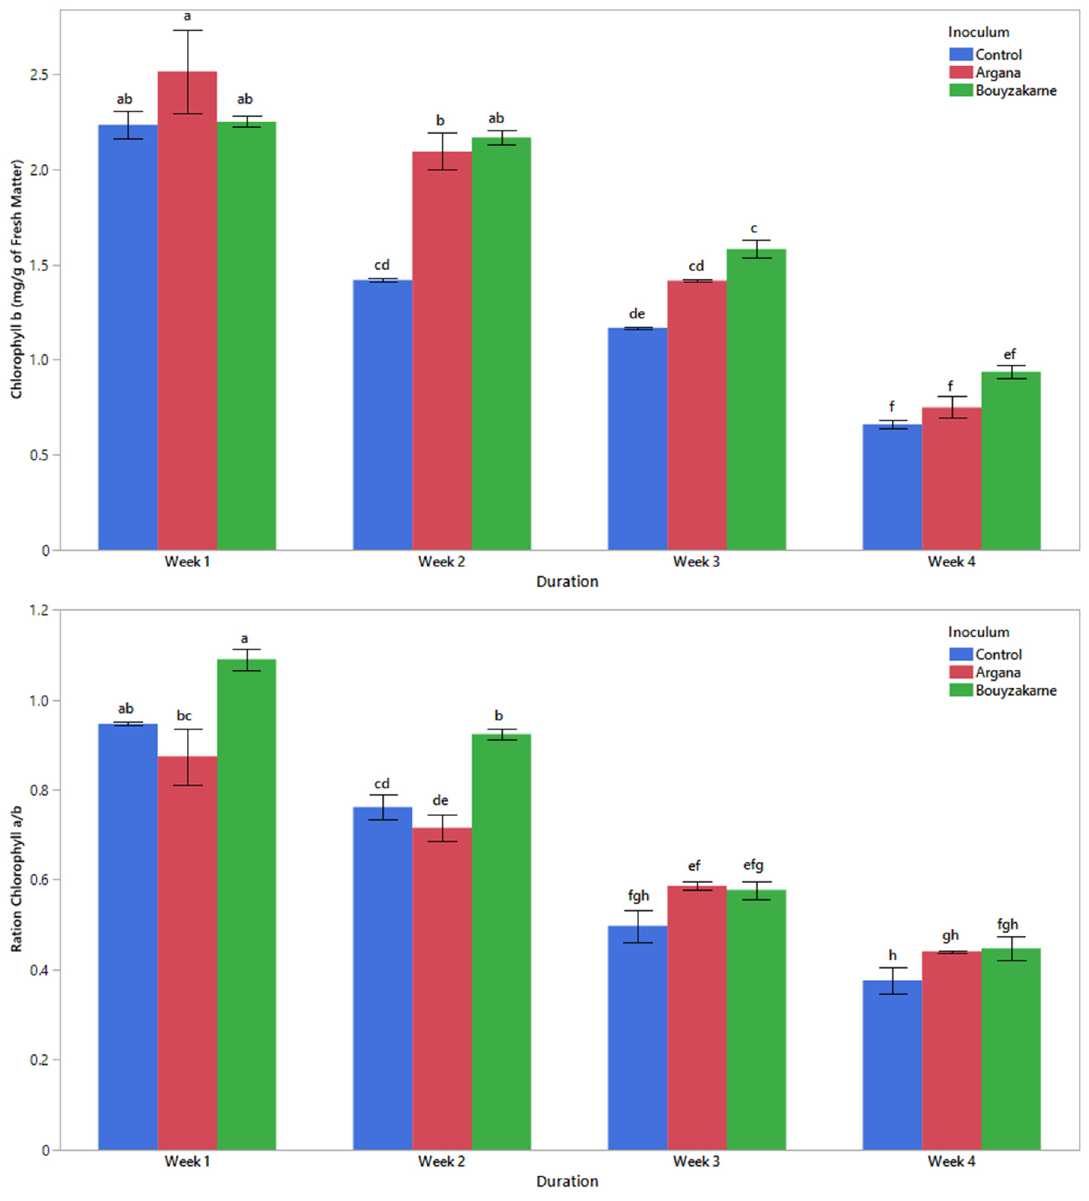
Figure 5. Chlorophyll a, b content and chlorophyll a/b (Chl a/b) ratio of mycorrhizal or non-mycorrhizal Argan plants, subjected to soil water deficit stress for one month (each error bar is constructed using 1 standard error from the mean). Values with different letters are significantly different (Tukey’s test p ≤ 0.05).